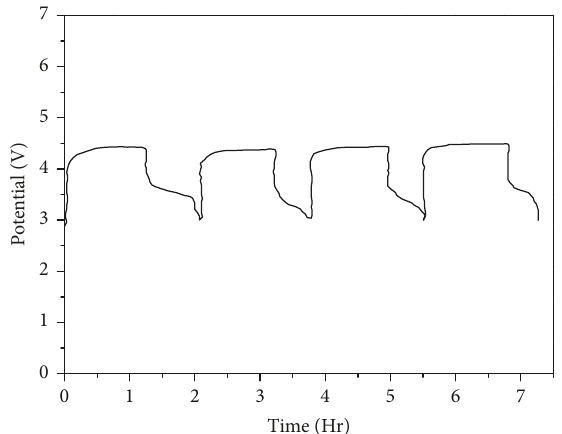
Figure 9: Variation of time versus potential of composite polymer electrolyte films for (70 :30) wt% ratio.